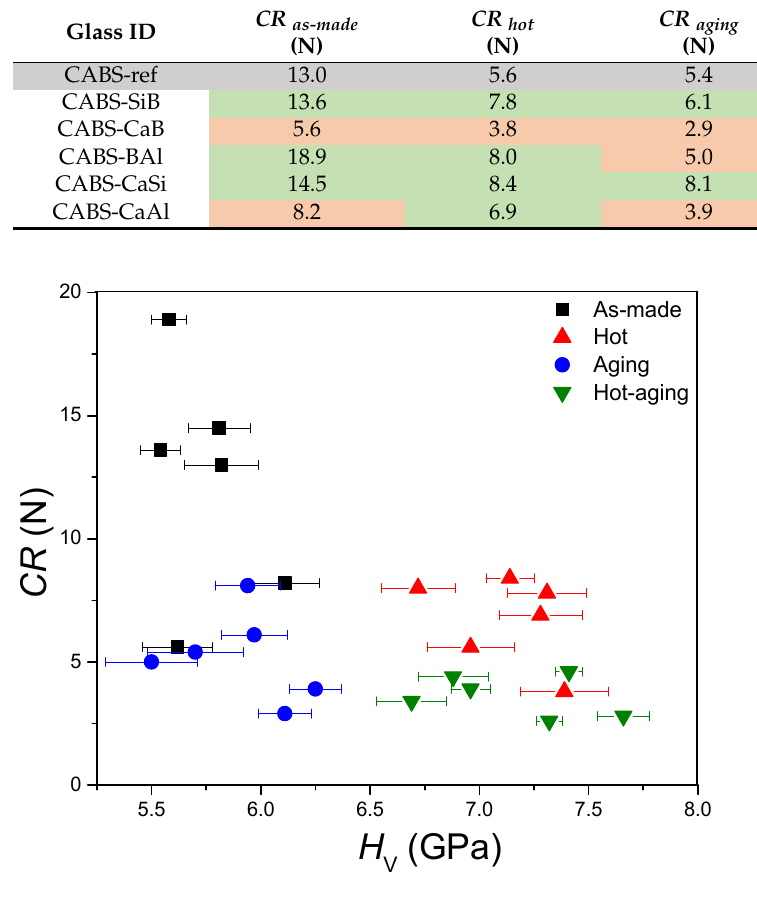
Figure 2. Relationship between crack resistance for Vickers indentation (CR) and hardness ( H V ) of the CABS glasses subjected to different post-treatment.